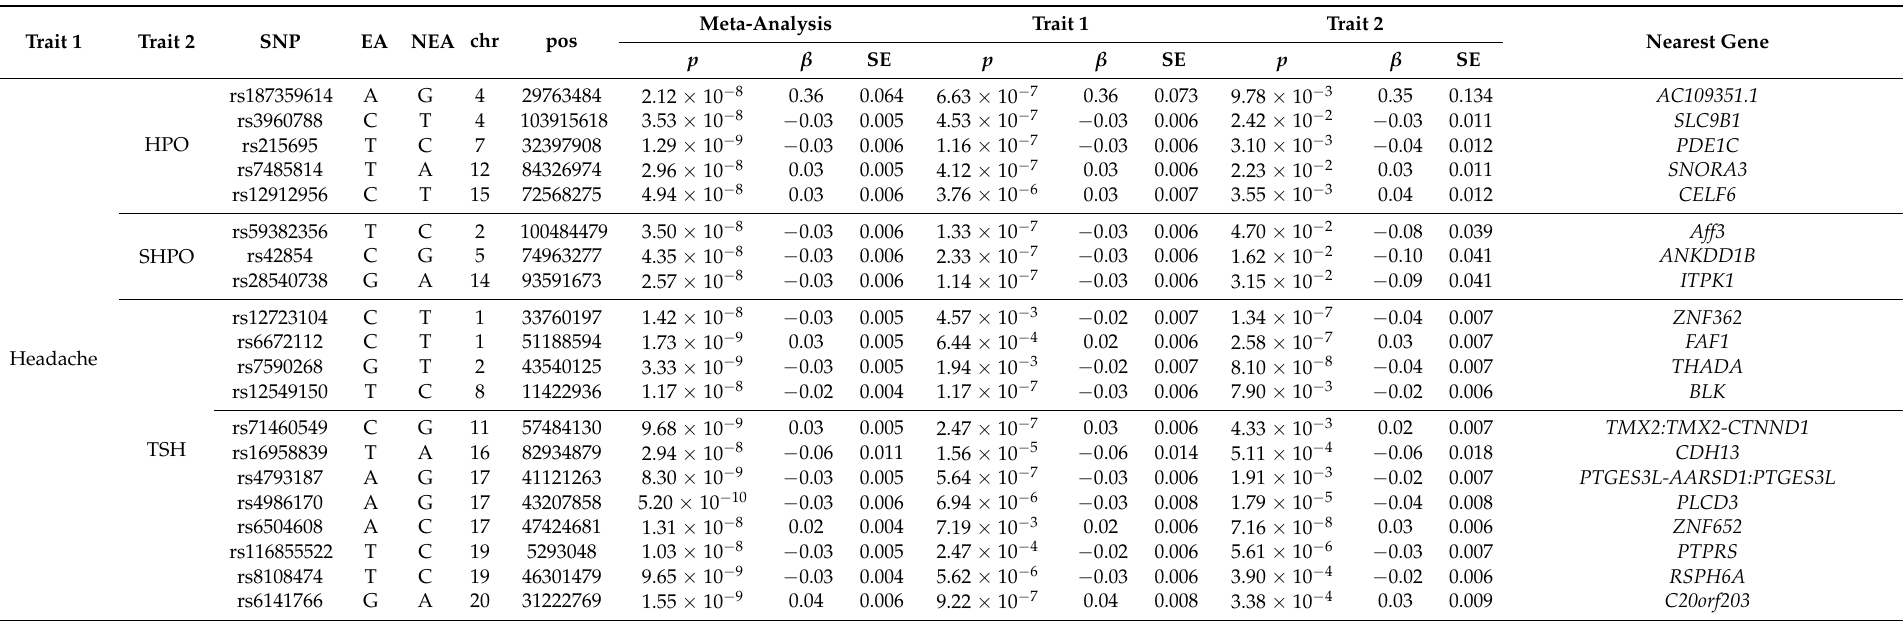
Table 2. Genome-wide significant SNPs from cross-trait meta-analysis between headache and thyroid